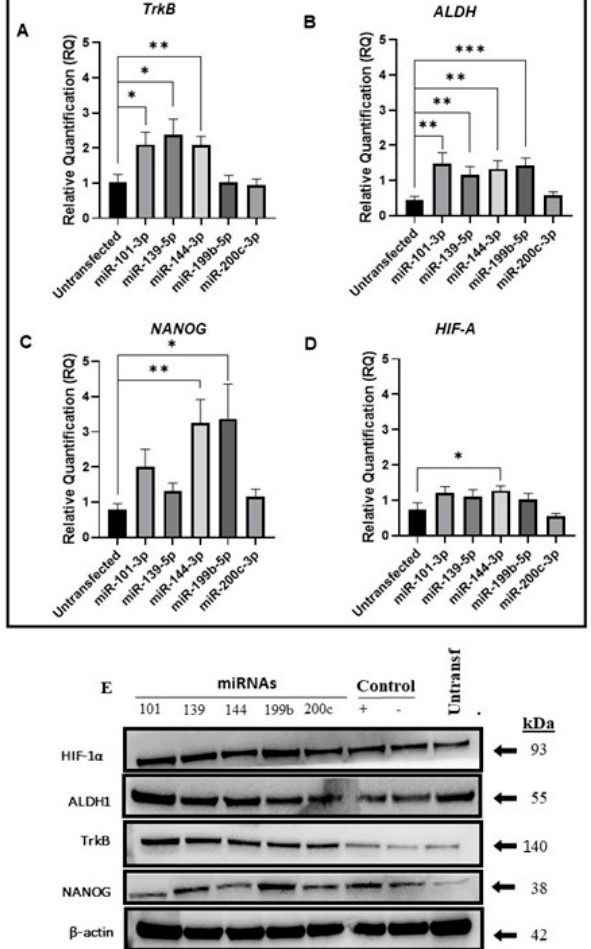
Figure 3. ZEB 1 suppression by miRNAs maintains cancer stem cell properties. mRNA expression levels of cancer stem cell-related genes ( A – D ). ( A ) Cells transfected with ZEB1 inhibitor miRNAs upregulate TrkB mRNA expression apart from miR-101-3p, miR-139-5p, and miR-144-3p ( t -test *, p = 0.02, *, p = 0.01, and **, p = 0.004, respectively). ( B ) miR-200c-3p does not affect ALDH mRNA expression compared to the other miRNAs, which increase its expression (Mann–Whitney **, p 101 = 0.009, t -test **, p 139 = 0.009, t -test ** p 144 = 0.002, and t -test ***, p 199 = 0.0006). ( C ) NANOG mRNA is significantly upregulated after transfection with miR-144-3p and miR-199b-5p and shows no significant upregulation for the other miRNAs ( t -test **, p = 0.002, and *, p = 0.02, respectively). ( D ) HIF-1 α mRNA levels are upregulated after transfection with miR-144-3p but shows no statistical significance for the other microRNAs ( t- test *, p = 0.03). ( E ) Western blot results of mRNA expression findings.